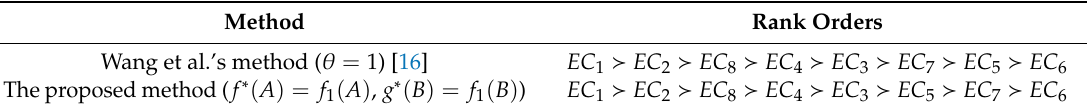
Table 12. The comparison between the proposed method and existing methods utilizing LZNs. Method Rank Orders Wang et al.’s method ( θ = 1) [16] EC 1 (cid:31) EC 2 (cid:31) EC 8 (cid:31) EC 4 (cid:31) EC 3 (cid:31) EC 7 (cid:31) EC 5 (cid:31) EC 6 The proposed method ( f ∗ ( A ) = f 1 ( A ) , g ∗ ( B ) = f 1 ( B )